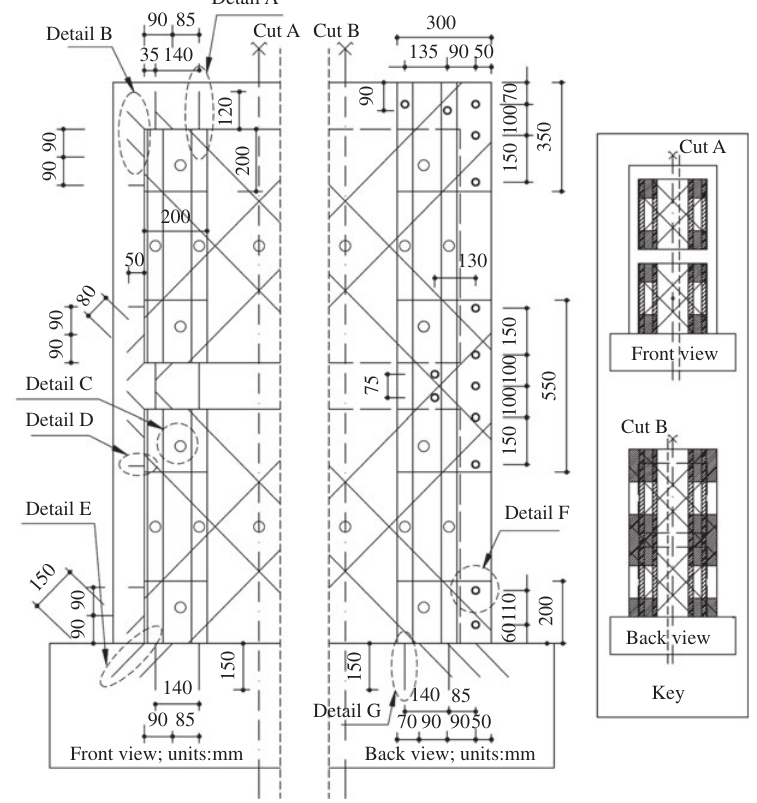
Figure 2 Strengthening details of specimen